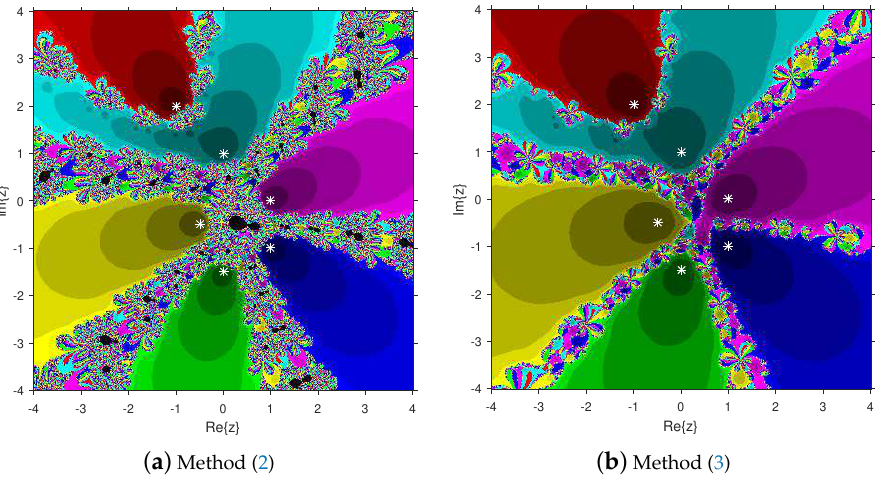
Figure 7. Comparison of attraction basins associated with sixth degree polynomial O 7 ( z ) = z 6 − ( 1 + i ) z 4 − 1 ( 19 + 3 i ) z 3 + 1 ( 11 + i ) z 2 − 1 ( 19 + 3 i ) z + 3 − 3 i 0.5 z 5 + 11 2 4 4 4 4